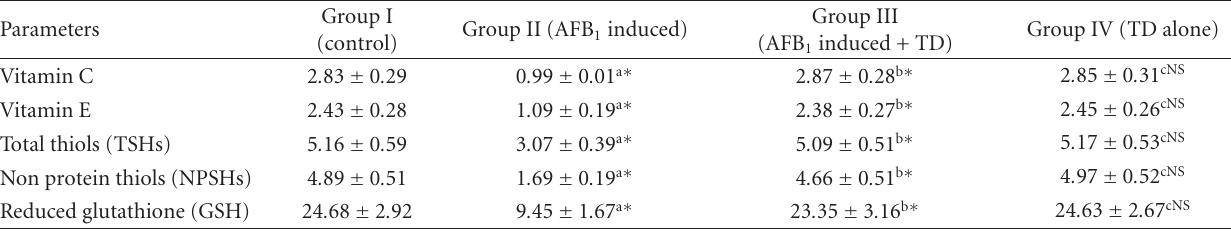
Table 3: E ff ect of TD on non enzymic antioxidants and thiols in serum of control and experimental animals.